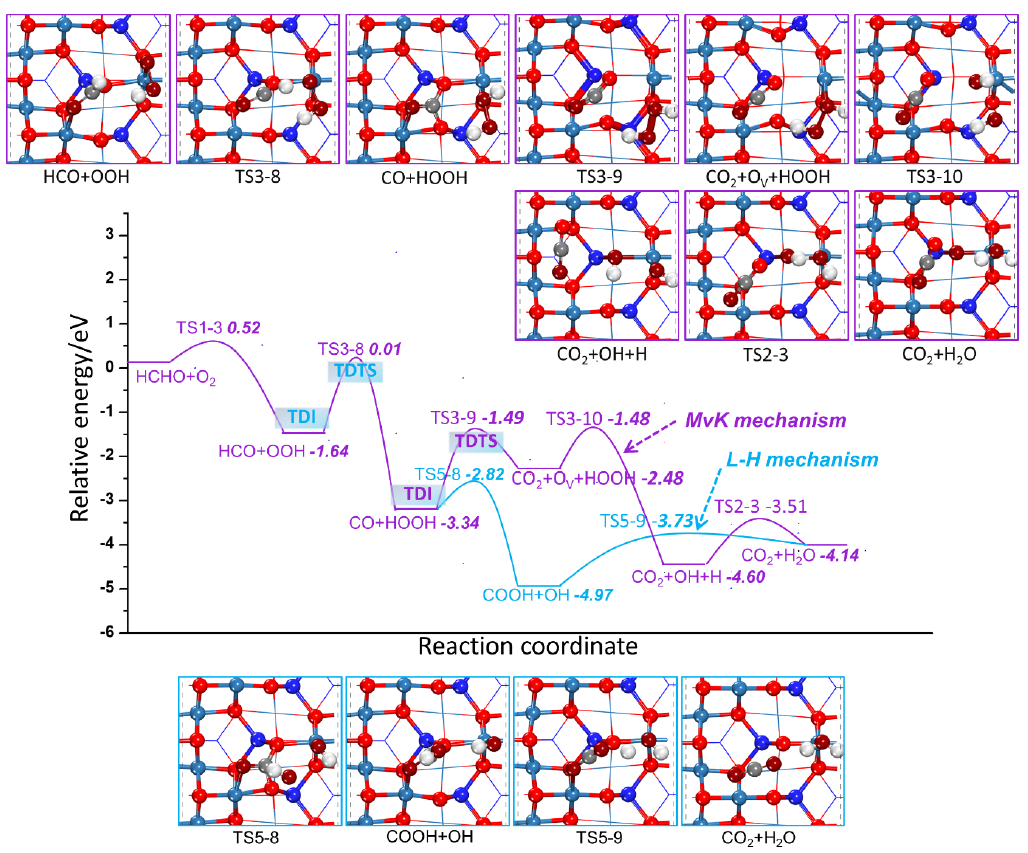
Figure 10. Potential energy diagram for the most favorable pathways of HCHO catalytic oxidation through the MvK and L-H mechanism.